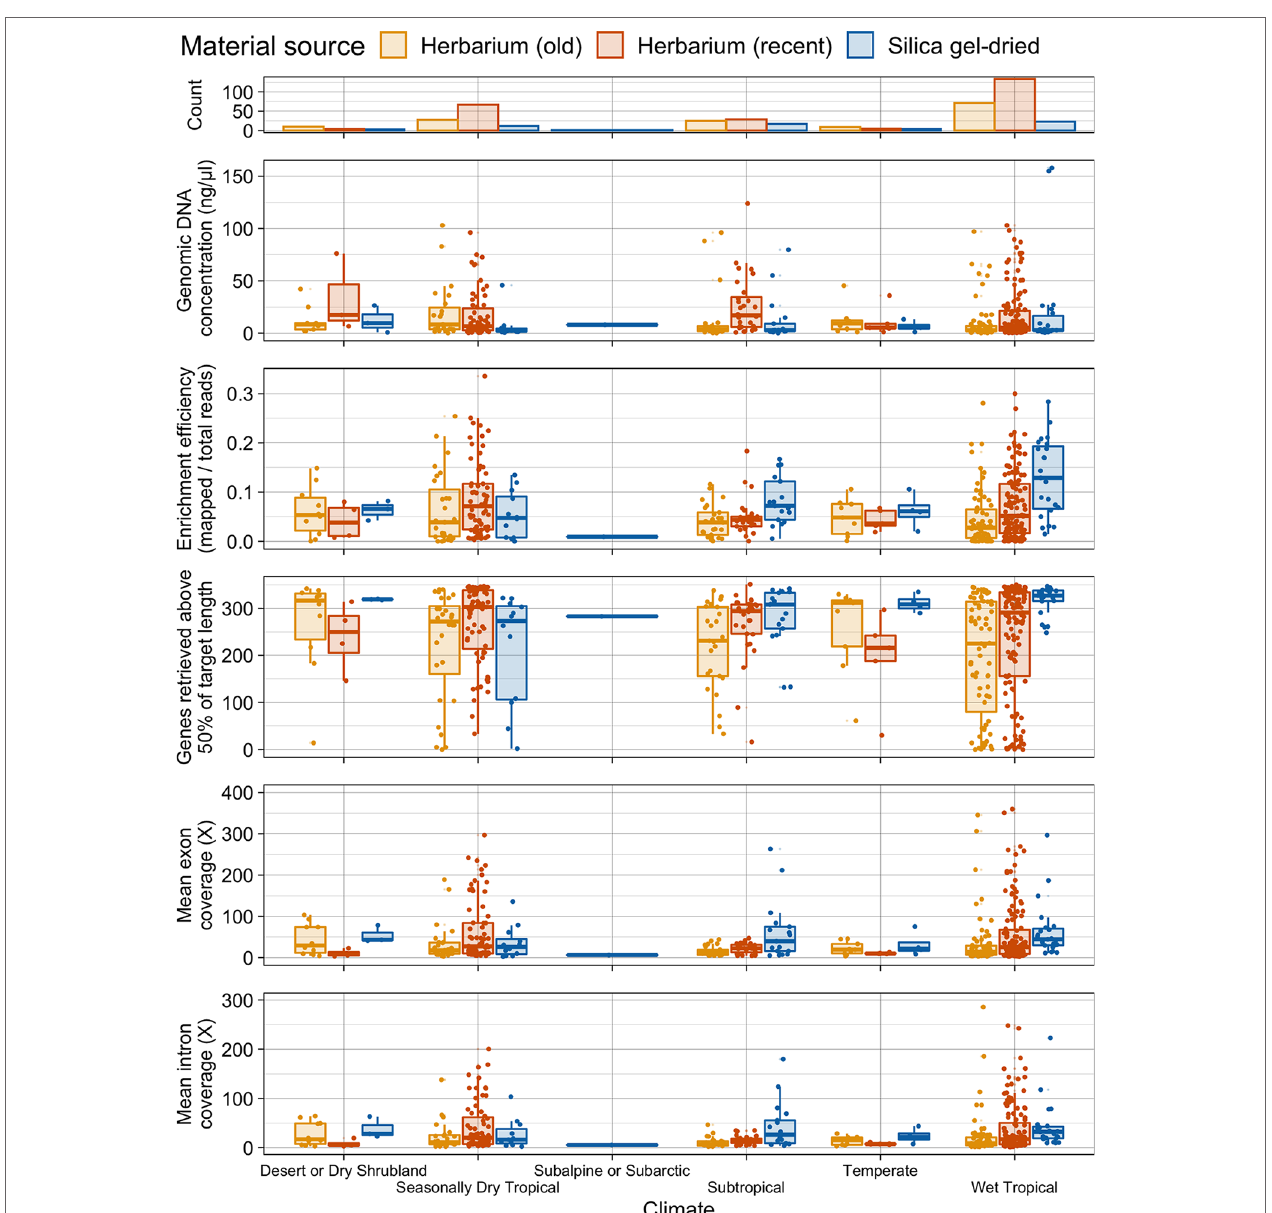
FIGURE 4 | Number of specimens per climate and distribution of genomic DNA concentration (ng/µl), enrichment efficiency (mapped/total reads), genes retrieved above 50% of target length, and mean exon and intron coverage (X) in each climate, grouped by material source. Each boxplot summarises the interquartile range and median.